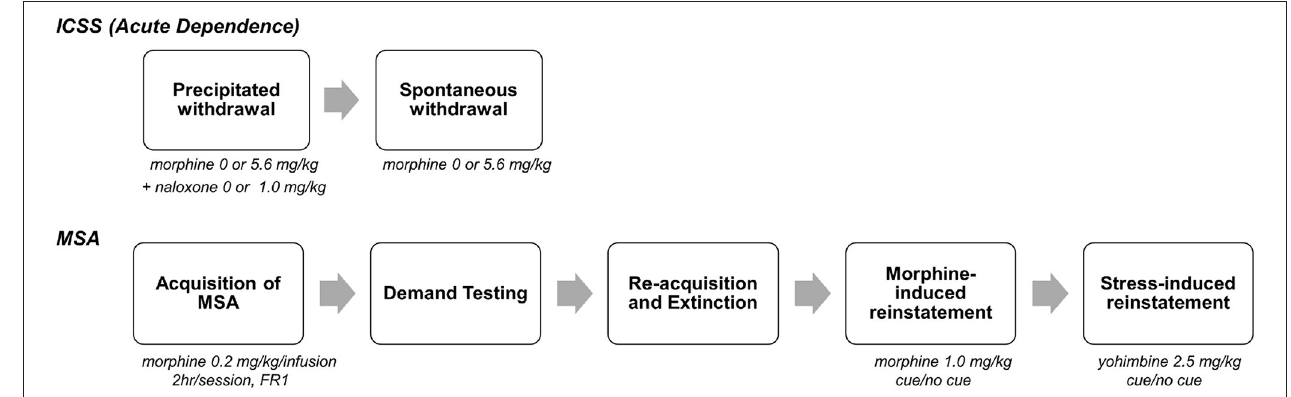
FIGURE 1 | Overview of experimental protocol. On each day, rats were injected with morphine (0 or 5.6, mg., s.c.), followed 1h 50min later by naloxone (0 or 1.0 mg/kg), and then tested for ICSS 10min later. After precipitated withdrawal, rats were injected with morphine (0 or 5.6 mg/kg) and tested for ICSS at multiple time points (2–170h) after injection. After completion of spontaneous withdrawal testing, all animals were tested using various measures of MSA (e.g., acquisition, demand, reinstatement) in daily 2h sessions (phase 2). [See text and ( 14) for further details]. The current FA study used data from MSA (phase 2). Because MSA was not influenced by treatment during ICSS testing ( 14), all animals that completed the MSA protocol were included in this analysis ( N = 43). Portion of figure reprinted by permission from Springer Nature (14), copyright